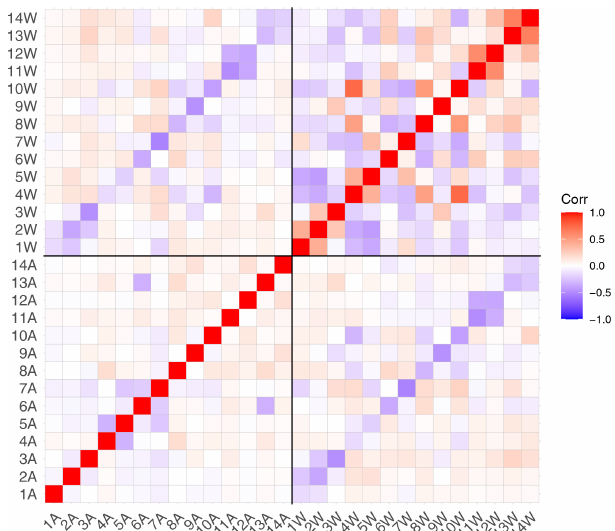
Figure 6. Posterior error correlations between regional anthro- pogenic and wetland emissions. To examine error aliasing at a re- gional scale, anthropogenic emissions resolved on the 4 ◦ × 5 ◦ grid are aggregated to the 14 subcontinental regions in Fig. 1 used for optimizing wetland emissions. Numbers (1–14) indicate the region index as in Fig. 1. “A” and “W” stand for anthropogenic and wetland emissions, respectively. For example, 5A stands for anthropogenic emissions from temperate North